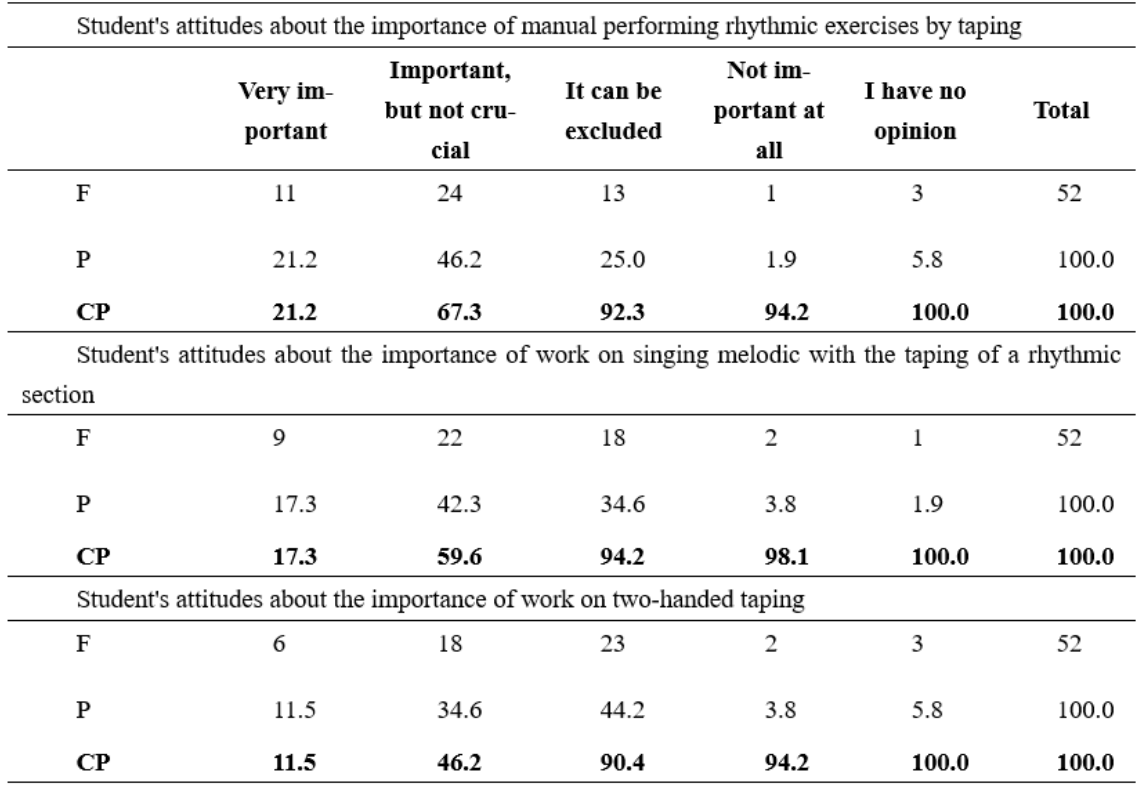
Table 13. Student's attitudes about the importance of work on certain segments in the rhythm area